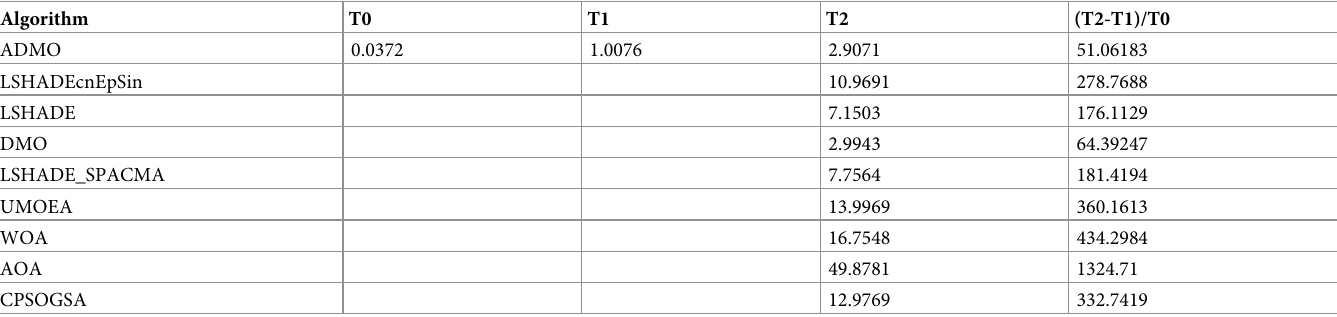
Table 4. Computational complexity for D=50.